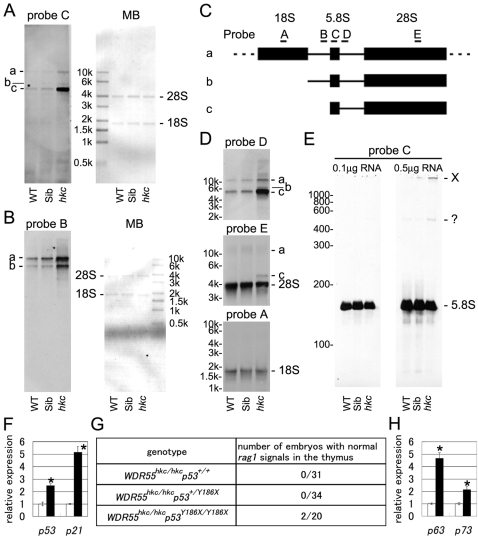
Defective rRNA processing and p53 activation in hkc mutants.(A–E) Detection of rRNA processing intermediates by Northern blot hybridization. Total cellular RNAs (0.5 µg per lane for probes A, C, and E; 0.1 µg per lane for probes B and D) in 7-dpf embryos from WT, siblings (Sib), and hkc mutants were electrophoresed in agarose gels and was hybridized with indicated probes (panels A, B, and D). Images of methylene blue (MB) staining are also shown. Indicated amount of total cellular RNAs in 7-dpf embryos from WT, siblings (Sib), and hkc mutants were electrophoresed in polyacrylamide gel and hybridized with probe C (panel E). Predicted structures of intermediates a-c and positions of probes A–E are drawn (panel C). In panel E, the hkc lane shows an increase in slowly electrophoresed signal (designated as X), perhaps corresponding to the mixture of the intermediates described in panel C. The amount of housekeeping cytoplasmic actin mRNA measured by quantitative RT-PCR was not significantly different among same-weight total cellular RNAs isolated from WT, Sib, and hkc mutants. Along with data showing that the intensities of the bands for 28S, 18S, and 5.8S rRNAs were comparable among these three groups of cells, these results suggest that the total amounts of rRNAs were comparable among these three groups of the cells. (F) Quantitative RT-PCR analysis of indicated genes in whole bodies of 7-dpf WT (open bars) and hkc mutants (closed bars). Results represent averages and standard errors of four independent measurements. Asterisks, p<0.05. (G) Phenotypes of WDR55hkc/hkcp53Y186X/Y186X embryos. Whole-mount in situ hybridization of rag1 was carried out with 5- to 7-dpf embryos obtained from WDR55+/hkcp53Y186X/Y186X× WDR55+/hkcp53Y186X/Y186X crosses or WDR55+/hkcp53+/Y186X× WDR55+/hkcp53+/Y186X crosses. (H) Quantitative RT-PCR analysis of indicated genes in whole bodies of 7-dpf WT (open bars) and p53Y186X/Y186X mutants (closed bars). Results represent averages and standard errors of four independent measurements. Asterisks, p<0.05.